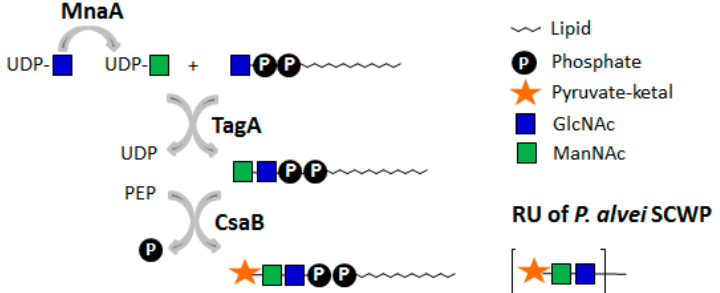
Figure 5. In vitro one-pot reaction involving the Paenibacillus alvei enzymes MnaA, TagA, and CsaB in combination with a synthetic lipid-PP-GlcNAc primer, demonstrating the preference of P. alvei CsaB for a lipid-PP-linked disaccharide substrate [109]. Pyruvylation (CsaB) is indicated by a star. RU: repeating unit. Monosaccharide symbols are shown according to the Symbol Nomenclature for Glycans (SNFG) [45].